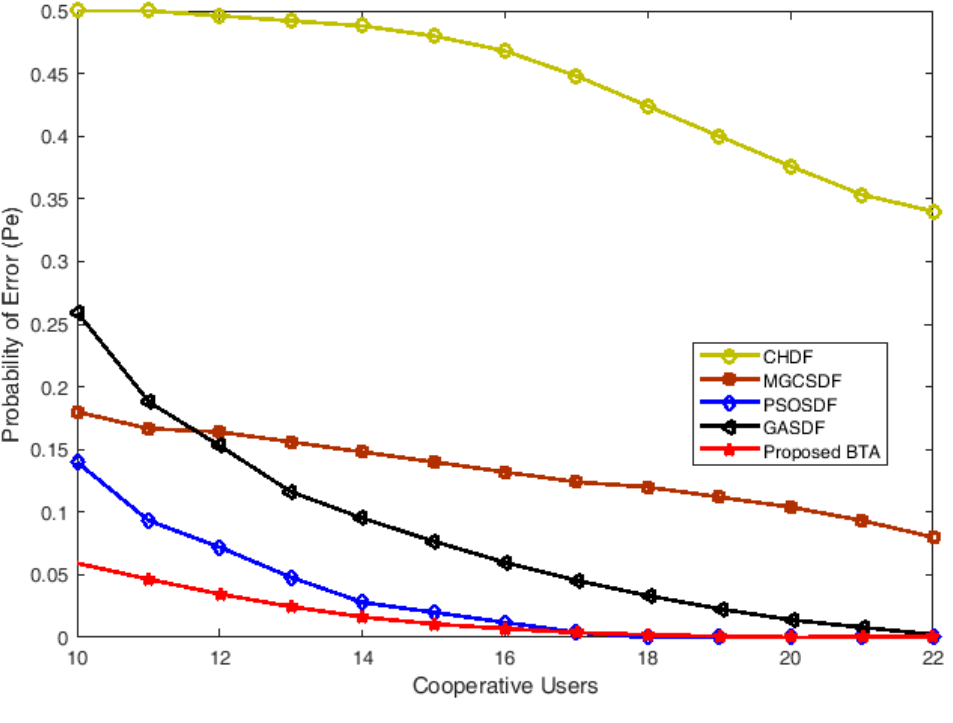
Figure 5. Probability of error vs. total cooperative users under normal users.